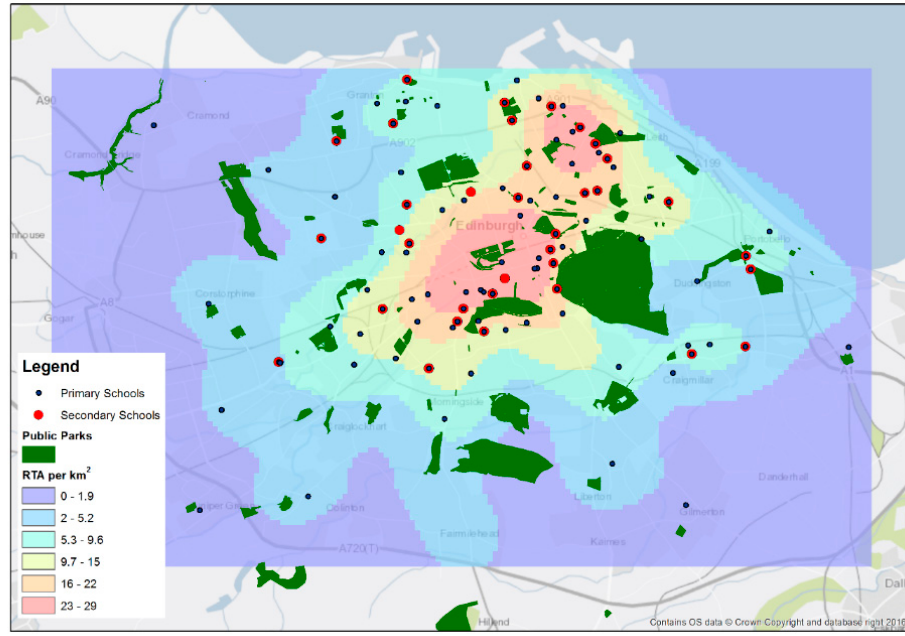
Figure 2. Public parks (1949) and the road traffic accident density (1937/1946) in Edinburgh, UK, in relation to primary and secondary schools.